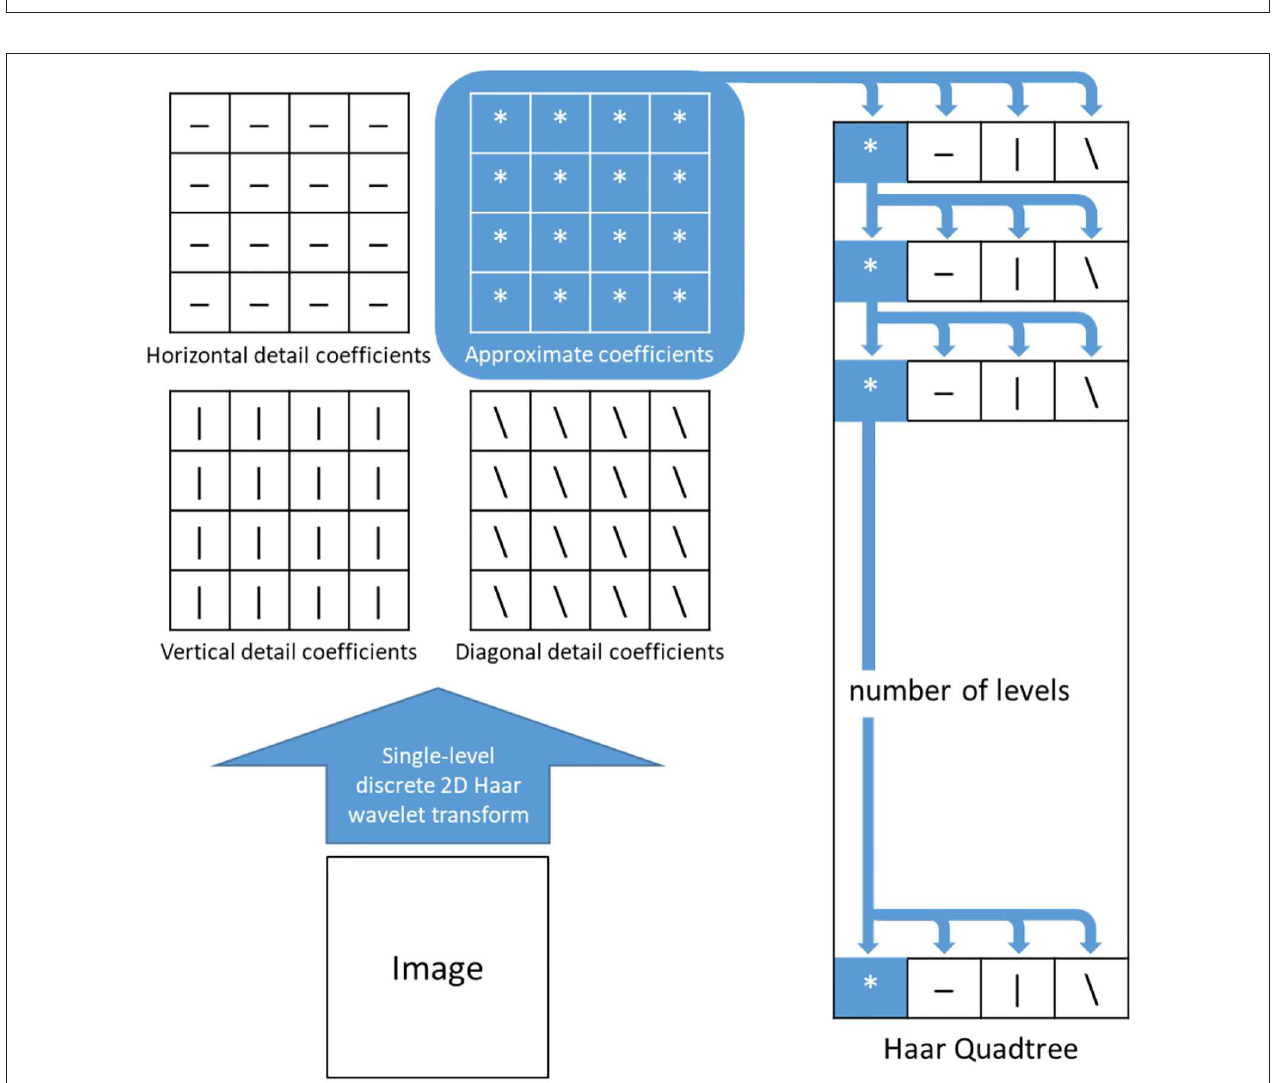
FIGURE 6 | Construction of Haar quadtrees using a single-level discrete 2D Haar wavelet transform. quadtrees. For the 2 nd level, 2D Haar wavelet transformation is applied on the approximation coefficients of the previous level and the outputs, with the four coefficients, are stored at that